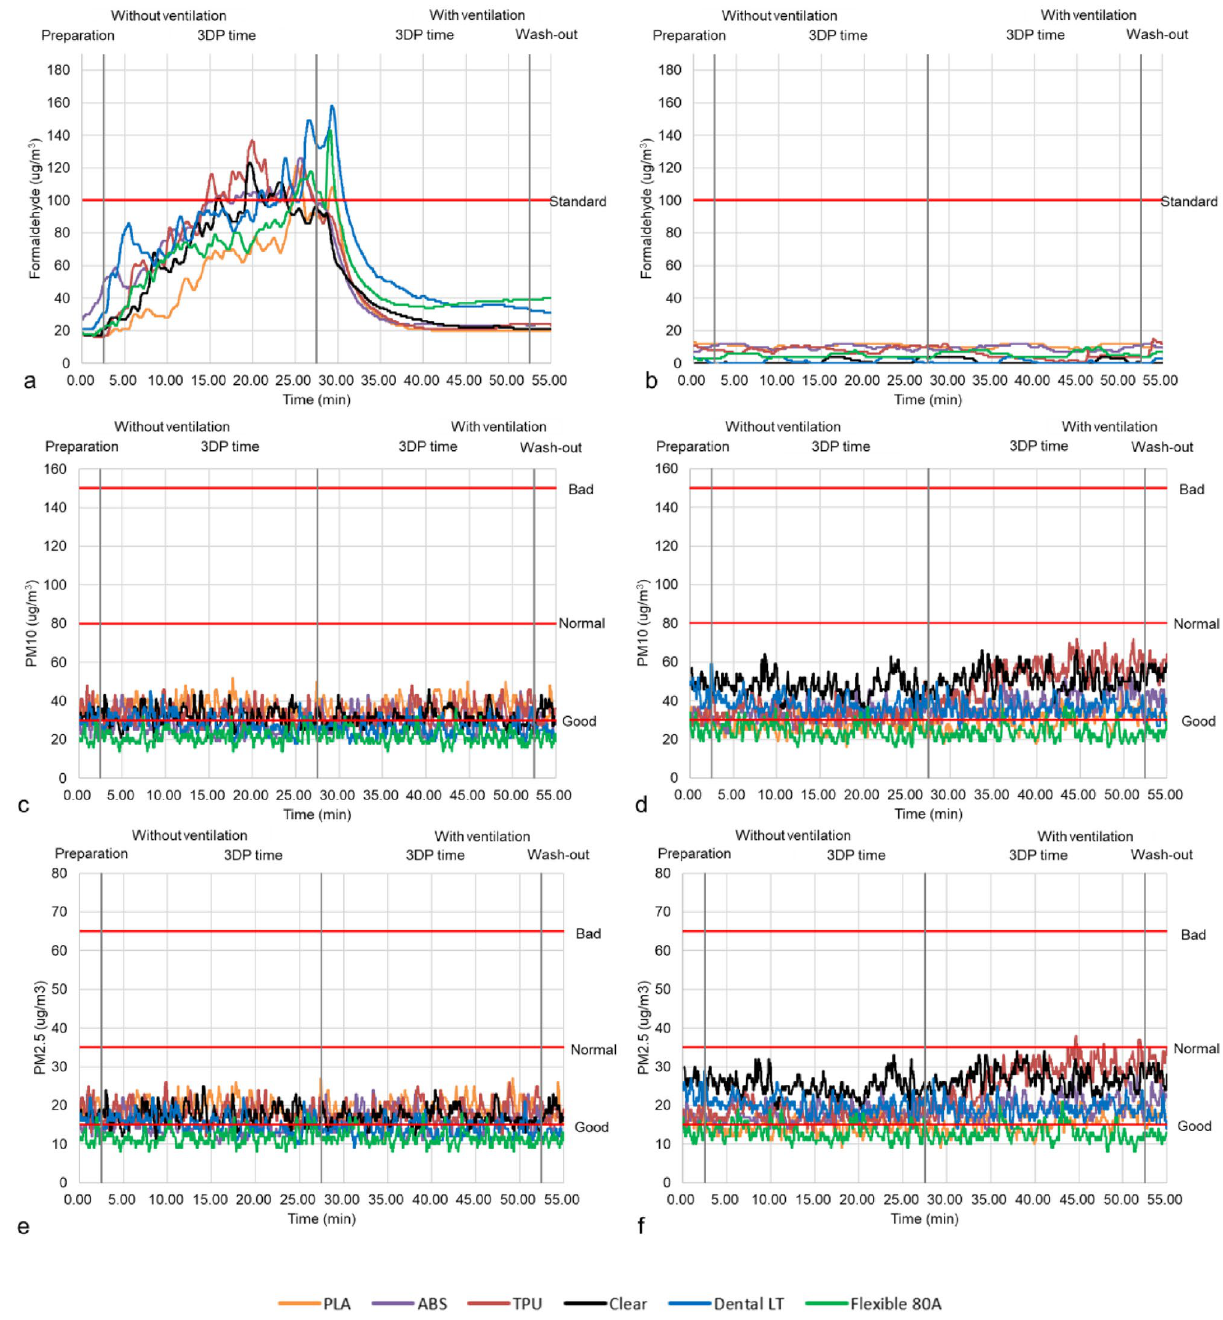
Figure 4. Test of emission amount for the polylactic acid (PLA), acrylonitrile butadiene styrene (ABS), and thermoplastic polyurethane (TPU) with materials extrusion (ME) and Clear, Dental LT, and Flexible 80A with the vat photopolymerization (VP) divided by 4 stages in the ( a ) 3D printing (3DP) workspace and ( b ) the control setting of formaldehyde, ( c ) the 3DP workspace and ( d ) the control setting of particulate matters 10 (PM 10 ), and ( e ) the 3DP workspace and ( f ) the control setting of particulate matters 2.5 (PM 2.5